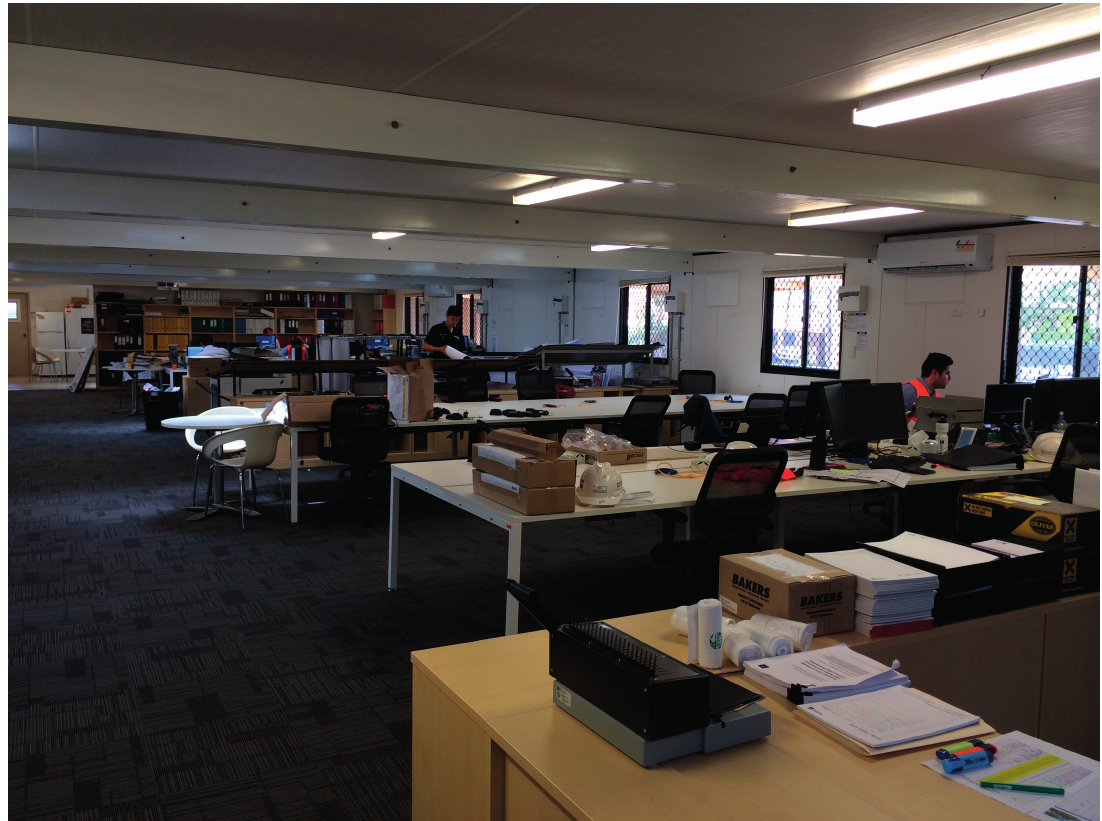
Figure 1. Bespoke open plan site office before plant